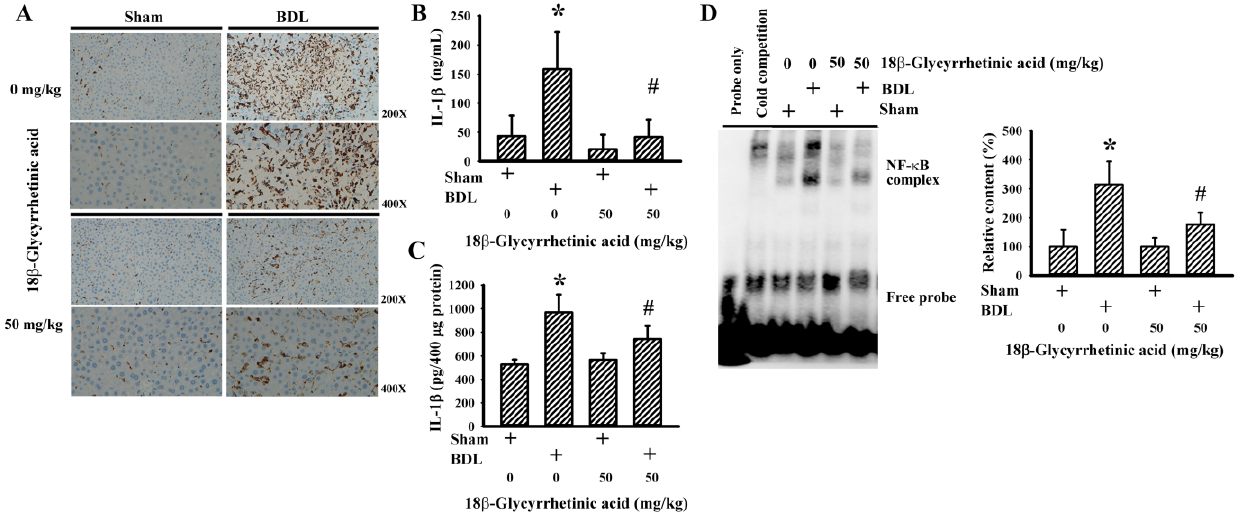
Figure 7. 18 β -Glycyrrhetinic acid alleviated BDL-induced inflammatory NF- κ B in the treatment